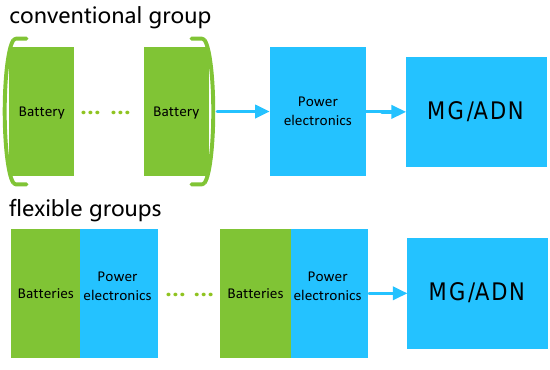
Figure 2. The diagram of a conventional group and flexible groups.